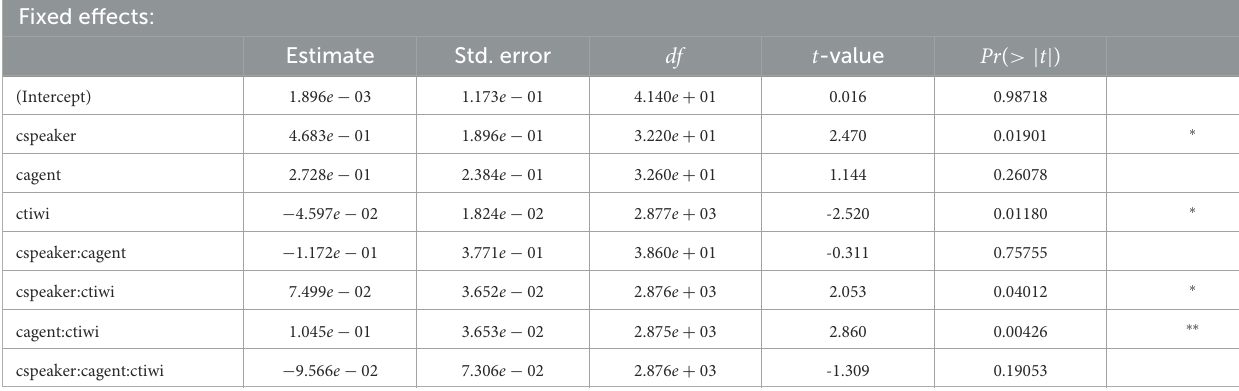
TABLE 5 Coefficients, SE s, df s, t -values, and p -values for the optimal model of logratios of target fixations for the shift time window in Experiment 3.